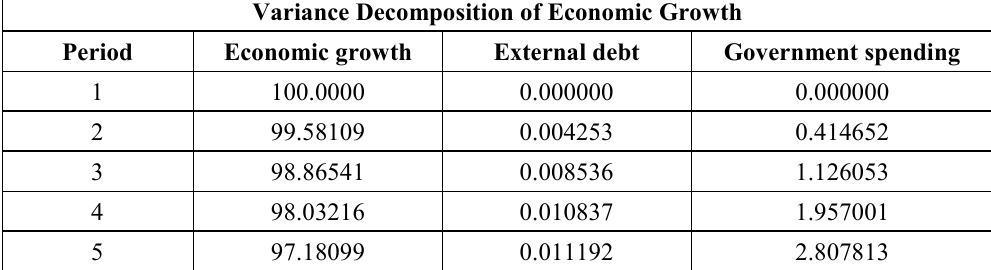
Table 11. Variance Decomposition of Economic Growth